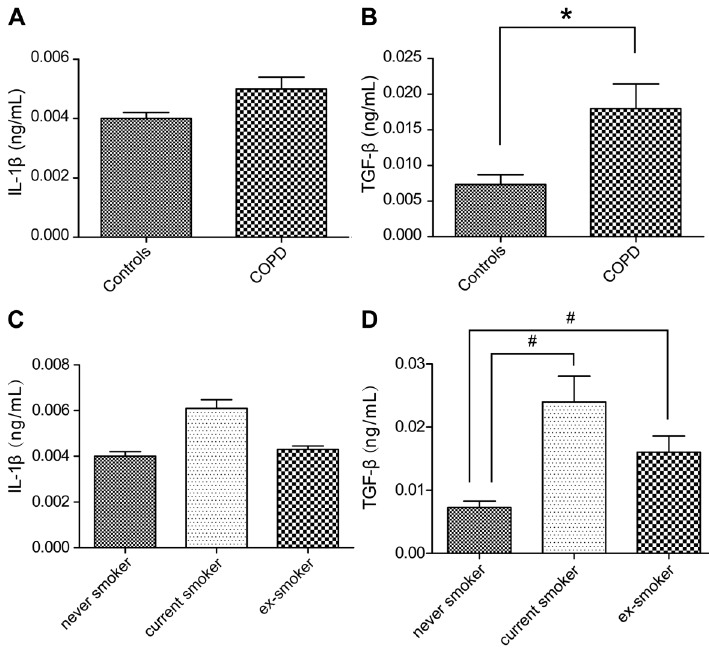
Figure 3. A , Plasma interleukin (IL)-1 b levels in healthy controls and patients with chronic obstruc- tive pulmonary disease (COPD). B , Plasma trans- forming growth factor (TGF)- b levels in healthy controls and COPD patients. C , Plasma IL-1 b levels among never, current, and ex-smokers. D , Plasma transforming growth factor (TGF)- b levels among never, current, and ex-smokers. *P o 0.05 vs controls; # P o 0.05 vs never smoker (Student ’ s t -test was used to compare two groups and one- way ANOVA was used to compare three